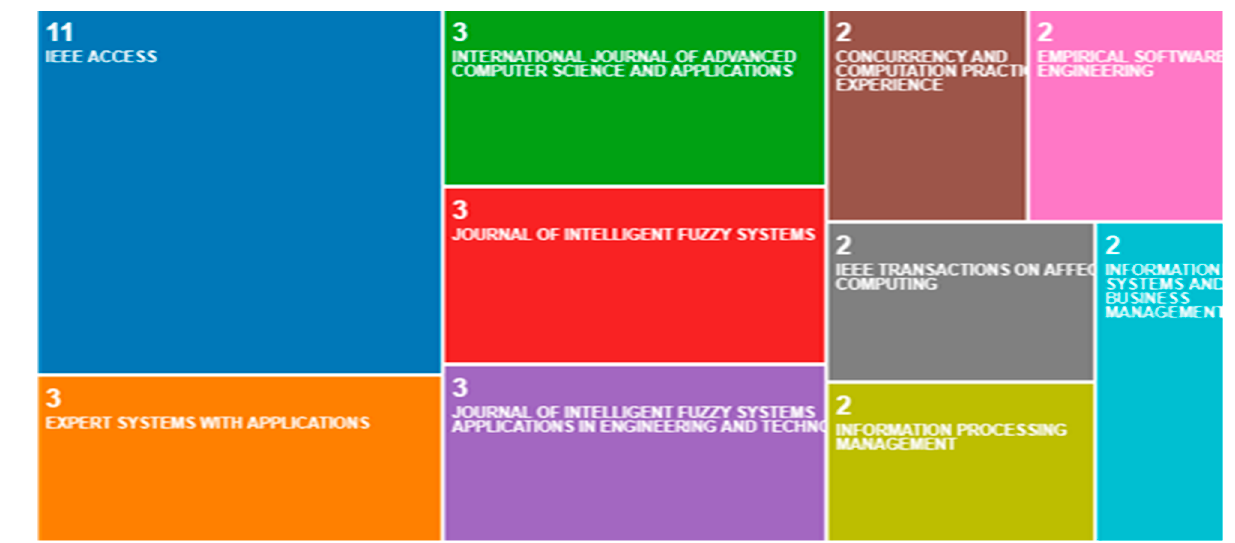
Figure 9. Analysis based on Web of Science source titles.